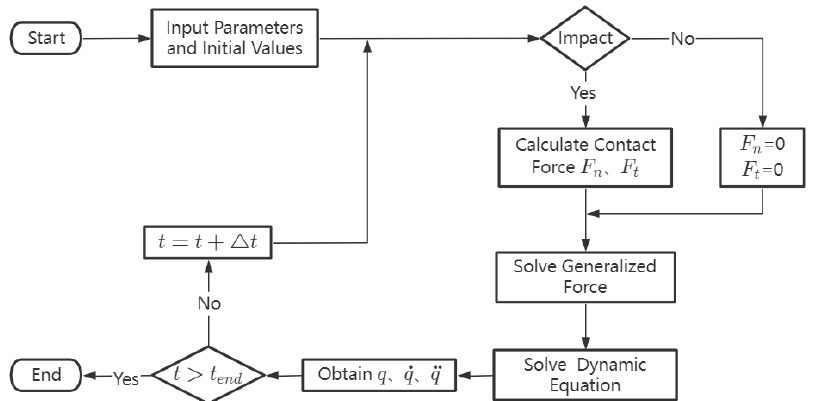
Figure 3. Flow chart for solving dynamic equation.